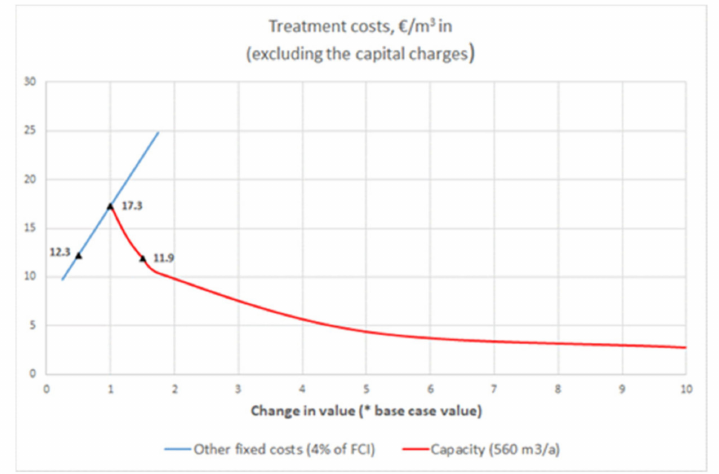
Figure 14. Sensitivity of treatment costs of case SepticWW#2 on selected process variables. The base case value of each parameter is shown in legend in